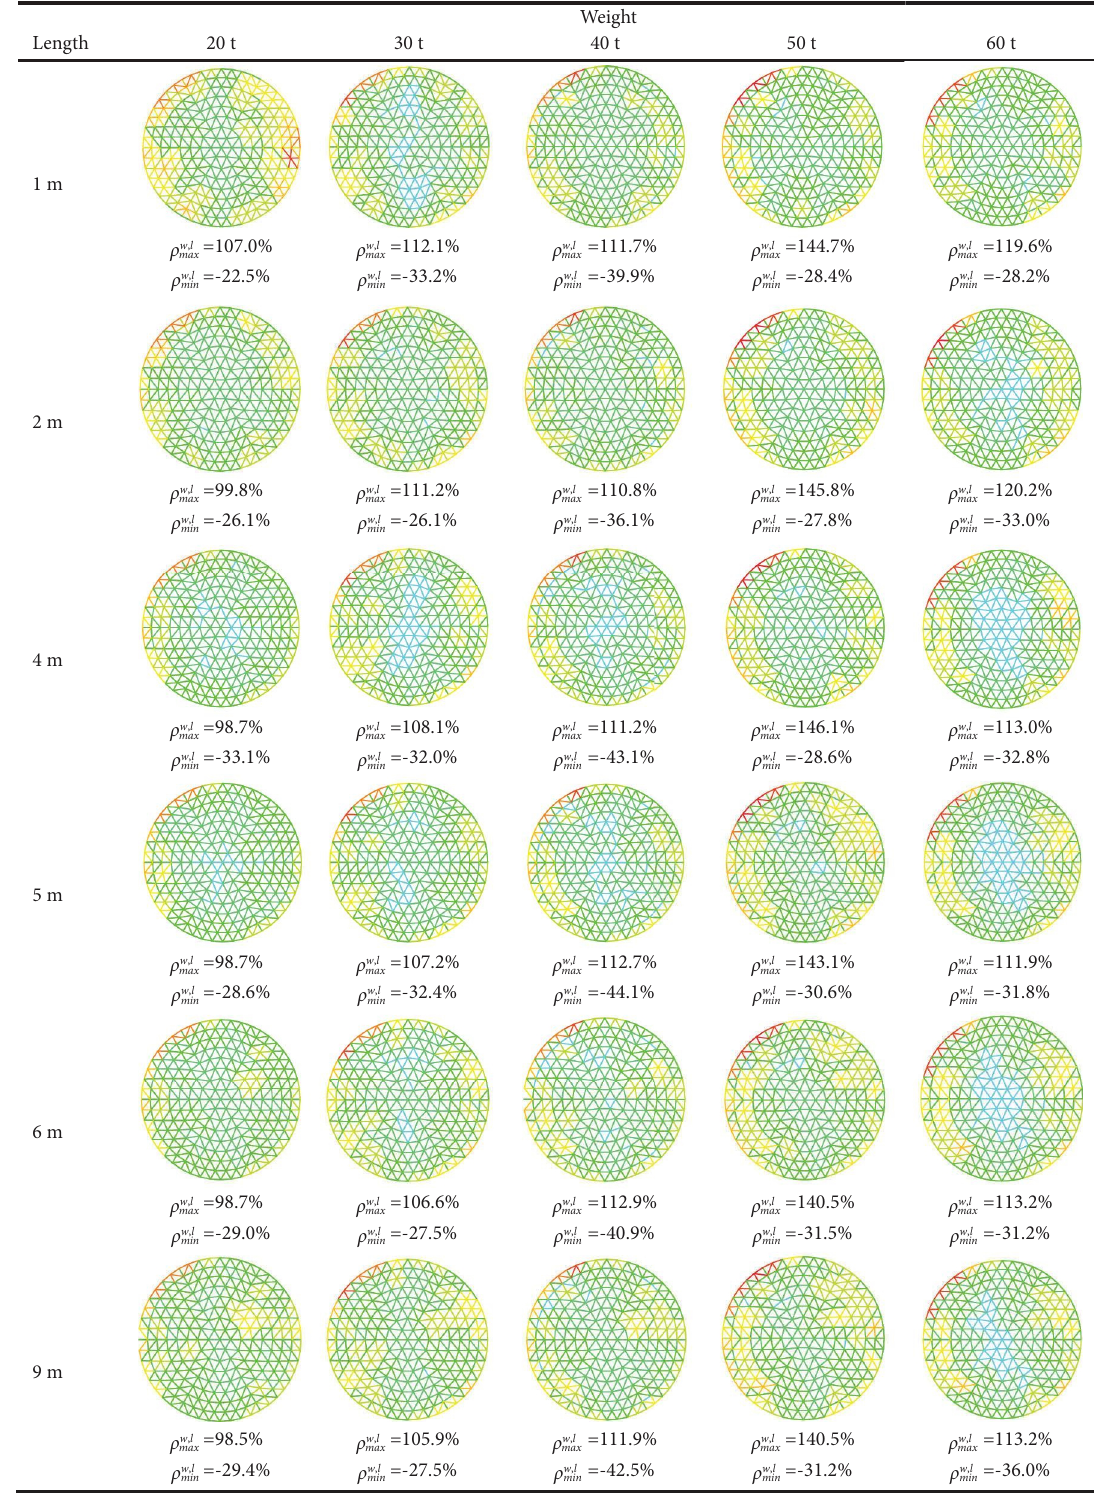
w,l , and ρ w,l values in the x i, max , ρ min max